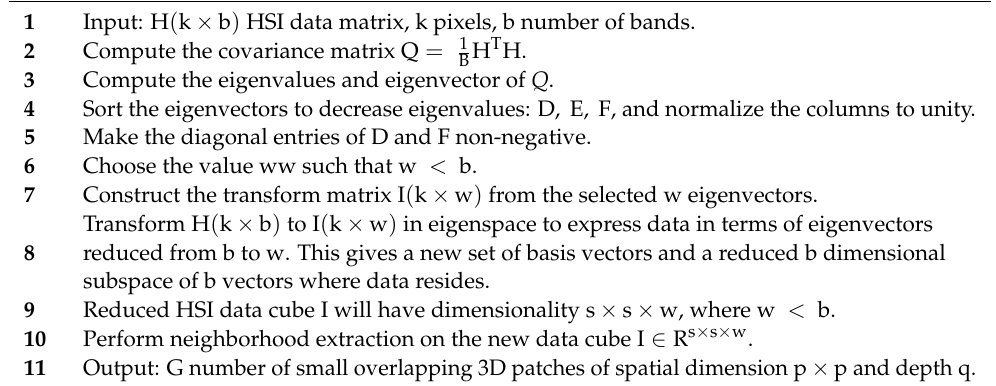
Algorithm 1: Spectral Data Reduction and Neighborhood Extraction